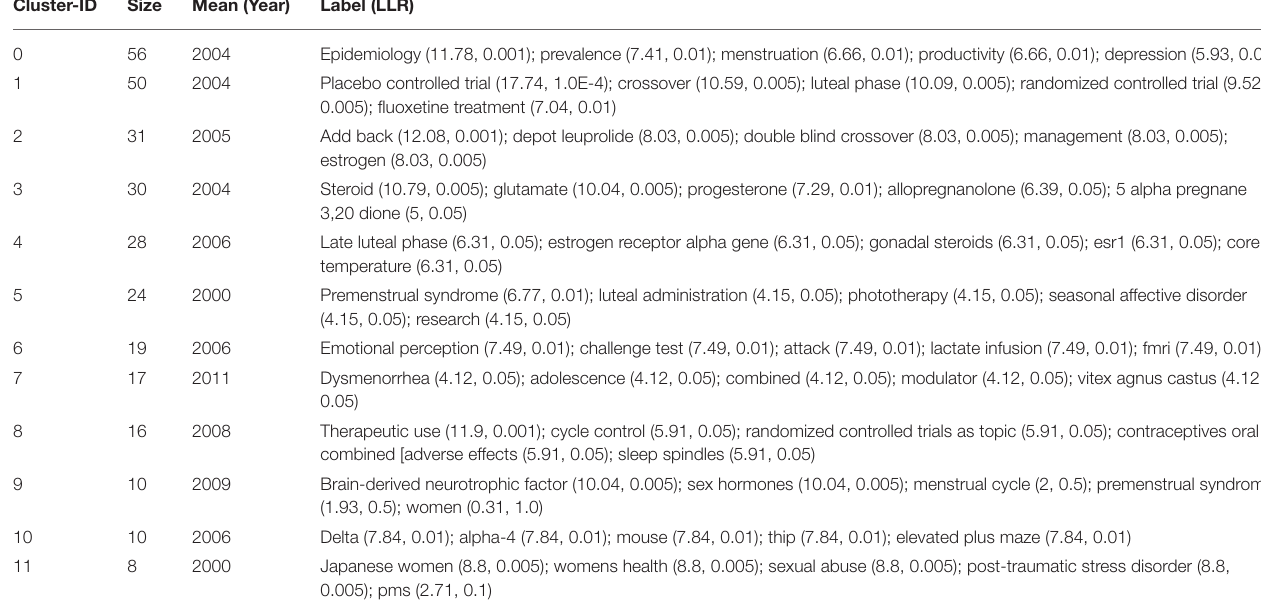
TABLE 4 | Clusters of keywords cooccurring in the top 100 cited papers on PMS/PMDD.